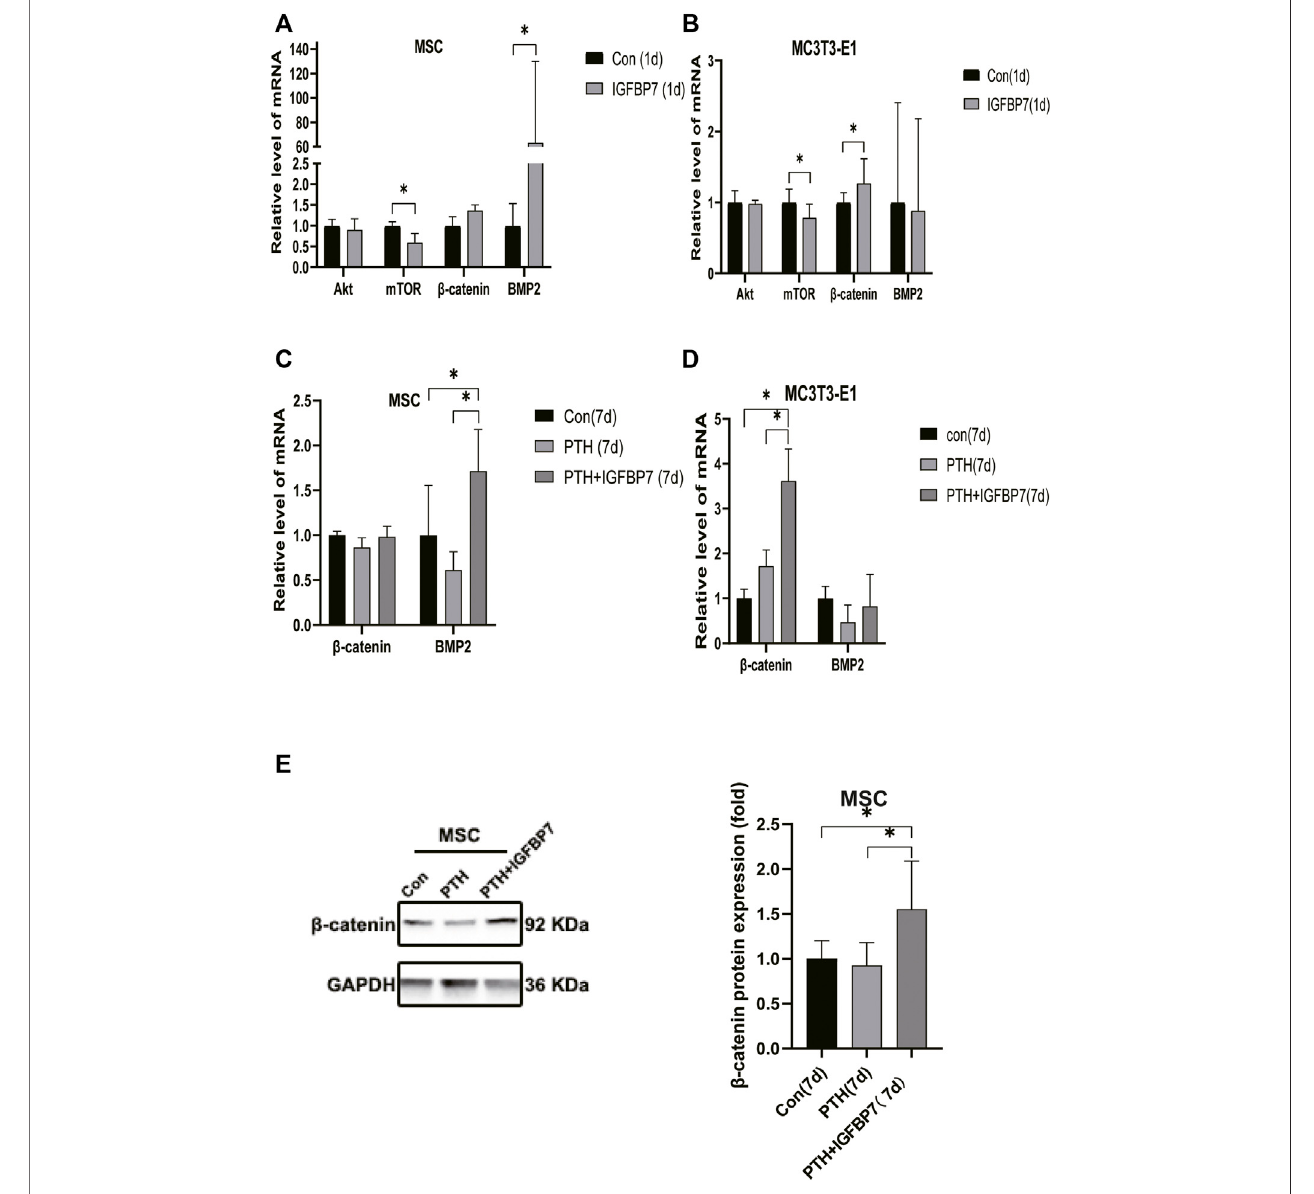
FIGURE 5 | Supplementation of IGFBP7 protein regulates the expression of mTOR, BMP2 and β -catenin. (A) The mRNA expression levels of Akt, mTOR, BMP2 and β -catenin in MSCs induced by supplementation using IGFBP7 for 24 h. (B) Relative mRNA expressions of Akt, mTOR, BMP2 and β -catenin in MC3T3-E1 cells induced by supplementation of IGFBP7 for 24 h. (C) Relative mRNA expression of β -catenin and BMP2 in MSCs induced by iPTH alone (PTH group) and IGFBP7 combined with PTH (PTH + IGFBP7 group) for 7 days. (D) Relative mRNA expression of β -catenin and BMP2 in MC3T3-E1 cells induced by iPTH alone (PTH group) and IGFBP7 combined with PTH (PTH + IGFBP7 group) for 7 days. (E) Relative expression of the β -catenin protein in MSCs induced by iPTH alone (PTH group) and IGFBP7 combined with PTH (PTH + IGFBP7 group) for 7 days * p <